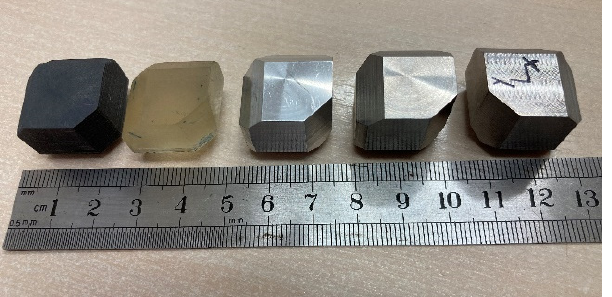
Figure 2. A CCD camera photo of five polygon samples—two fabricated from PLA polymer by the FDM AM technology (left), one made of commercial aluminum alloy by milling (center), and two made of Ti6Al4V—wrought (second from the right) and DED (right).